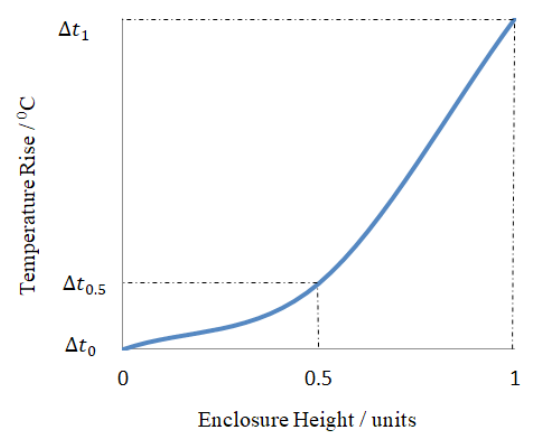
Figure 2: Predicted temperature profile with enclosure height of the Panel Board as per IEC TR 60890. Enclosure height is considered as a unit measurement.